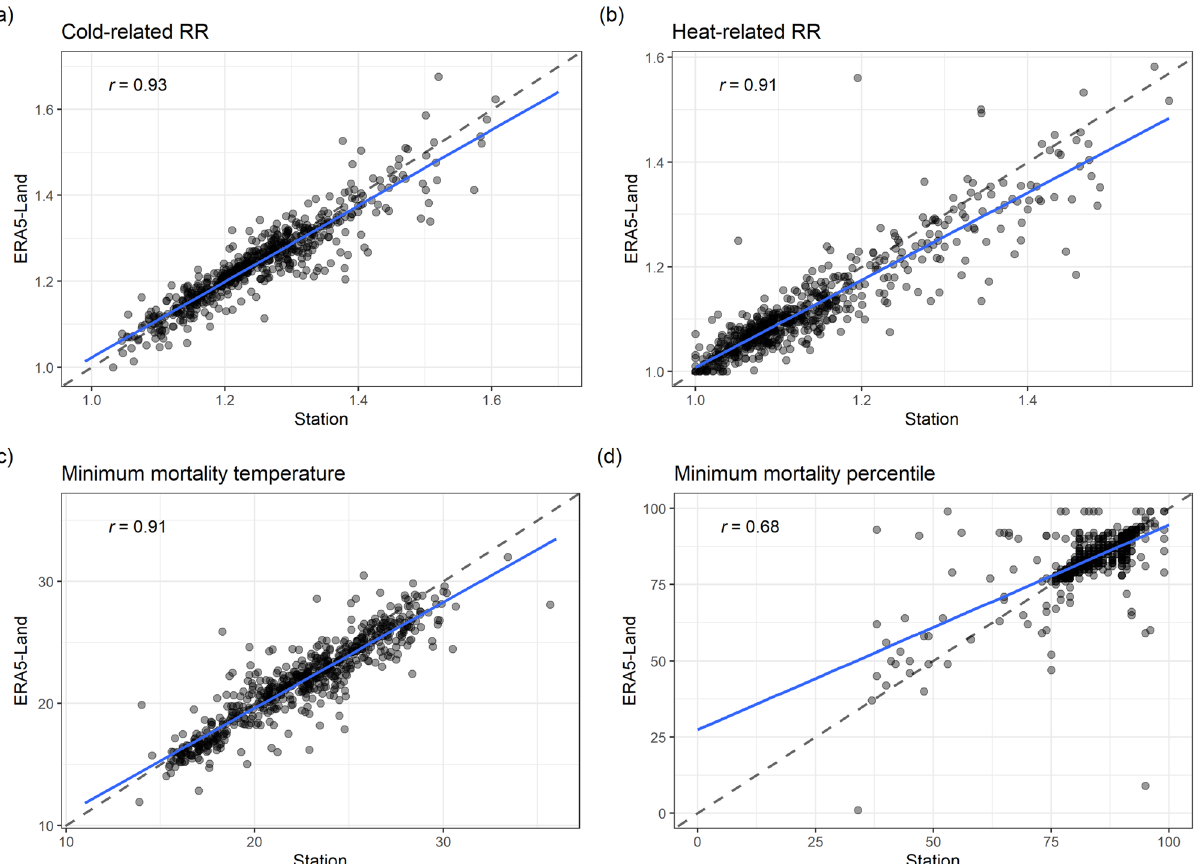
Figure 4. Scatterplots of: ( a ) and ( b ) cumulative relative risks (RRs) at the 1st and the 99th percentile respectively; ( c ) Minimum mortality temperature (MMT) and ( d ) Minimum mortality percentile (MMP). The RRs, MMP and MMT are based on the respective station and ERA5-Land temperatures of the best linear unbiased predictions (BLUPs) for individual cities. Blue lines and the r values represent the linear regression trend and the Pearson correlation coefficient of compared variables, respectively. The dashed black line represents the 1:1